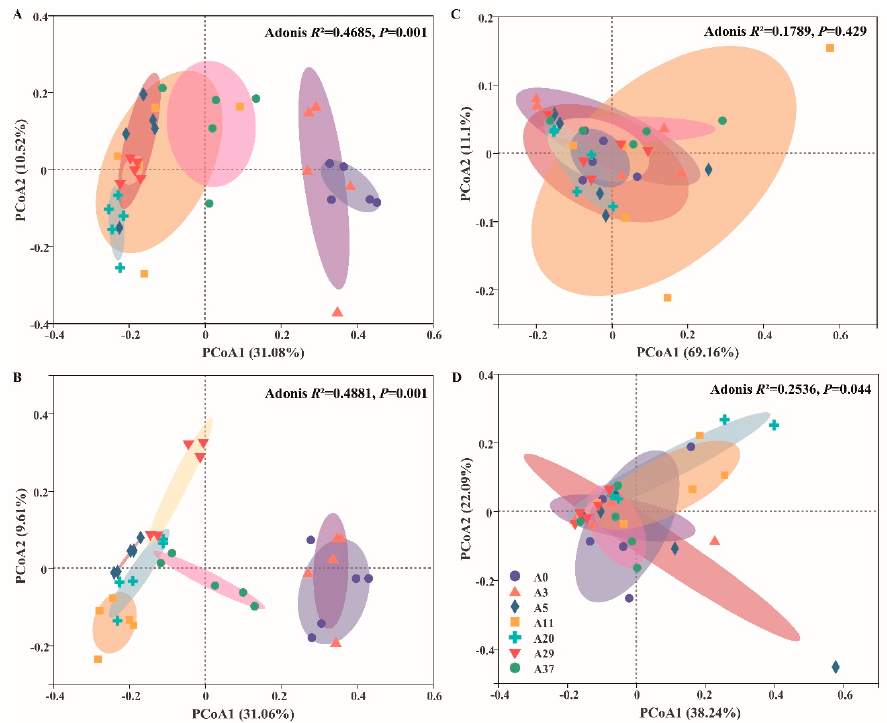
Figure 4. Principal coordinate analysis (PCoA) based on Bray–Curtis distances for differences between bacteria (( A ), 0–10 cm; ( B ), 10–20 cm) and fungi (( C ), 0–10 cm; ( D ), 10–20 cm) at the OTU level for different stages of afforestation by aerial sowing in the northeastern Tengger Desert, China. Adonis with 999 permutations was applied to test the effects of afforestation stages on community differences.